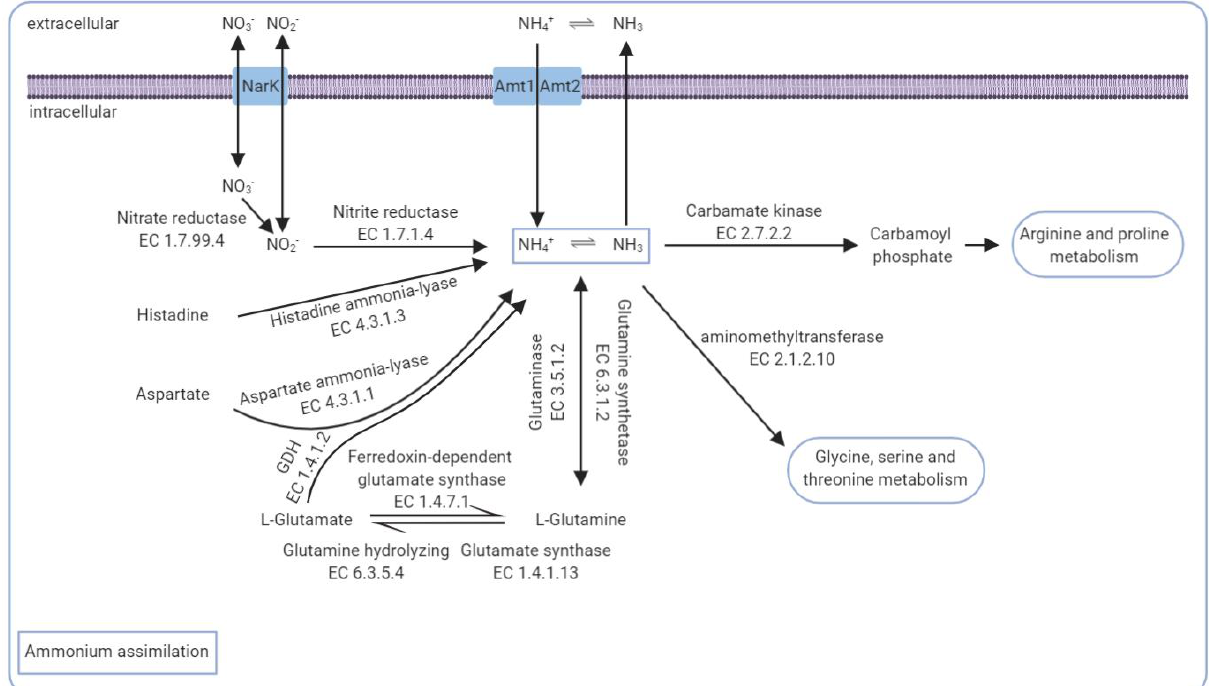
Figure 5. A hypothesis of ammonia conversion in Pseudomonas putida TT321 and Pseudomonas putida TT322. The ammonia conversion was adapted from [26,31]. All enzymes were found in studied ge- nomes.